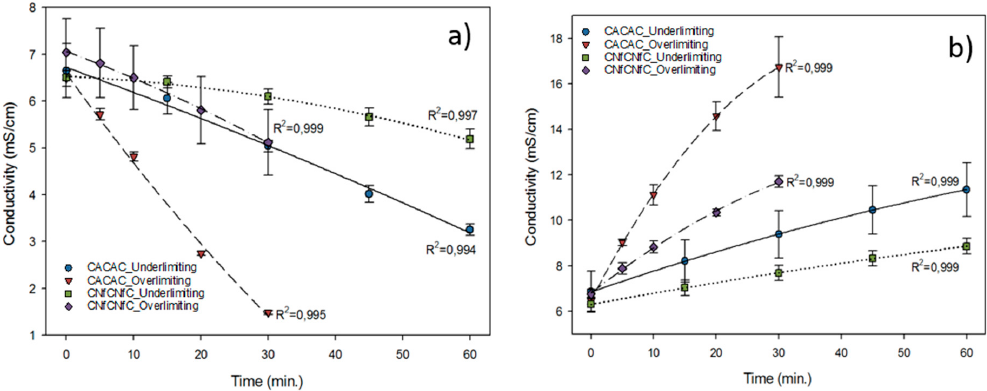
Figure6. ( a )Wheyand( b